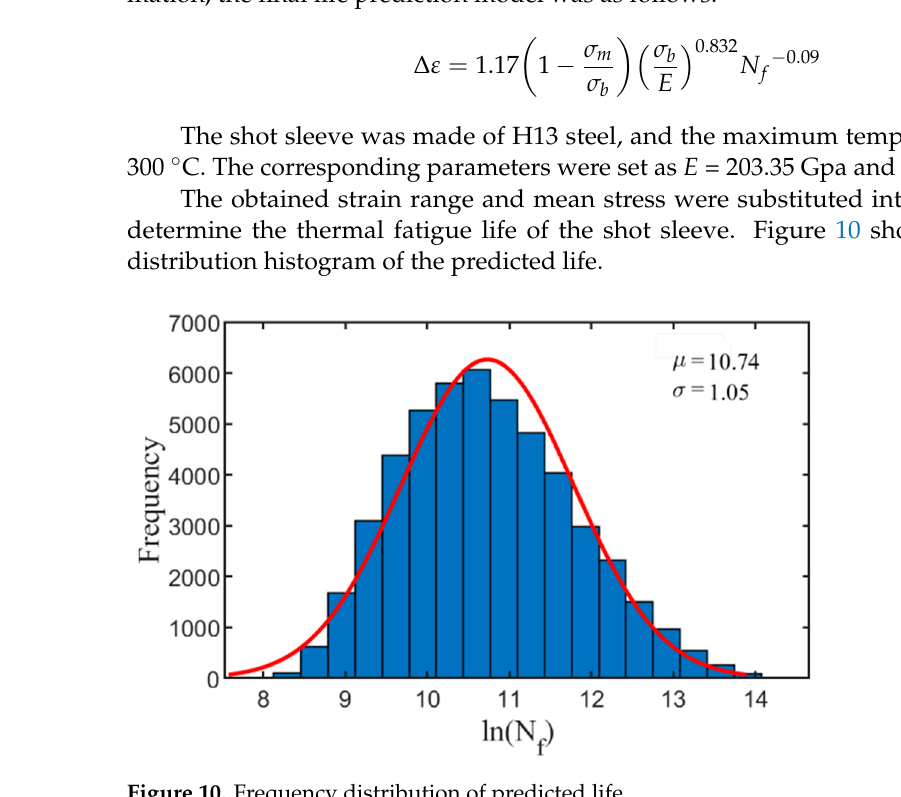
Figure 9. Frequency distribution of response values.